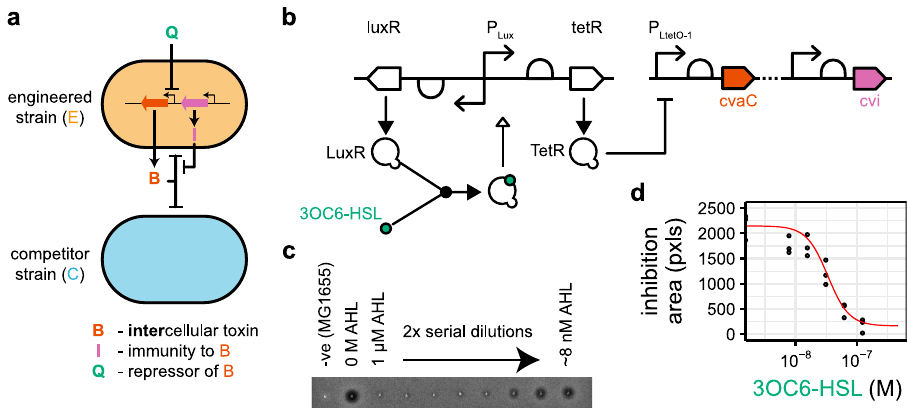
Fig. 4 Exogenous control of bacteriocin production. a The expression of bacteriocin can be controlled by the addition of a quorum molecule ( Q = 3OC6- HSL) into the environment. b The system is spread across two plasmids. 3OC6-HSL binds to LuxR, LuxR-AHL induces the expression of TetR, which represses bacteriocin expression. c Conditioned media from the growth of the engineered strain in a range of 3OC6-HSL concentrations was spotted onto a lawn of EcM-Gm-CFP (Supplementary Information) leading to zones of inhibition from bacteriocin killing. d The inhibition areas are quanti fi ed using an image processing pipeline and used to fi t a Hill function for bacteriocin expression. The image in c shows a representative slice from a larger plate containing three replicates (Supplementary Fig. 3). In d , points show values of three replicates. The red line shows the fi tted Hill function.